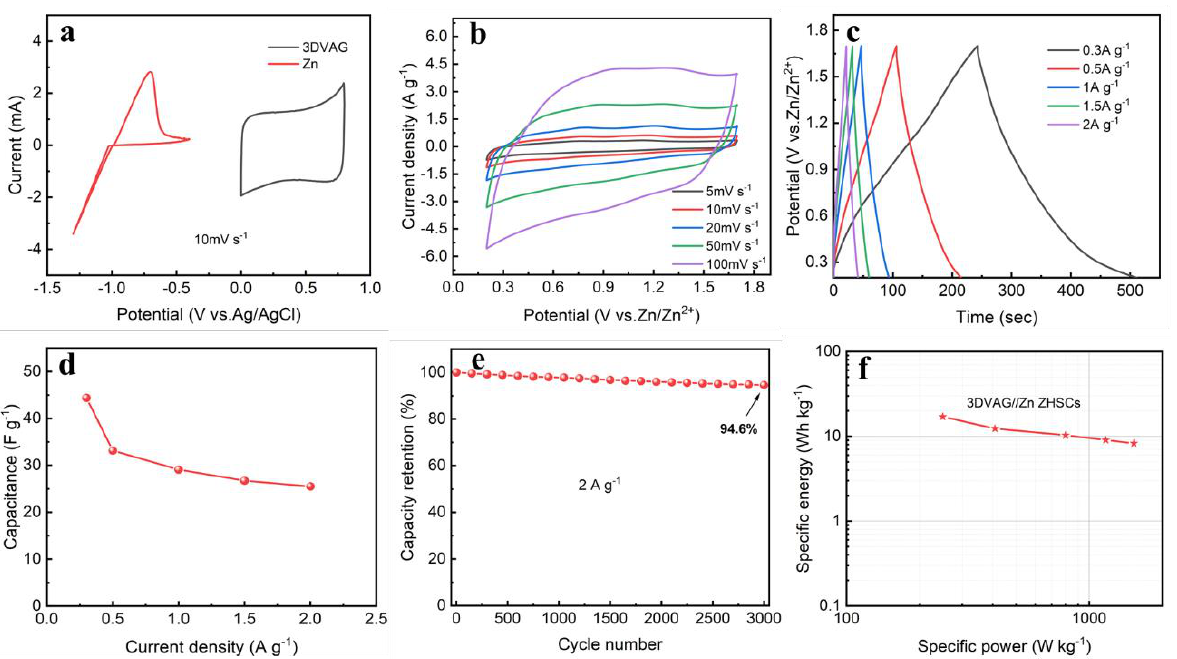
Figure 10. Electrochemical performance of ZHSCs constructed by 3DVAG materials: ( a ) carbon − based aqueous zinc ion hybrid supercapacitor; ( b ) CV curve; ( c ) GCD curves at different current densities; ( d ) rate performance; ( e ) cycle life; ( f ) Ragone diagram.